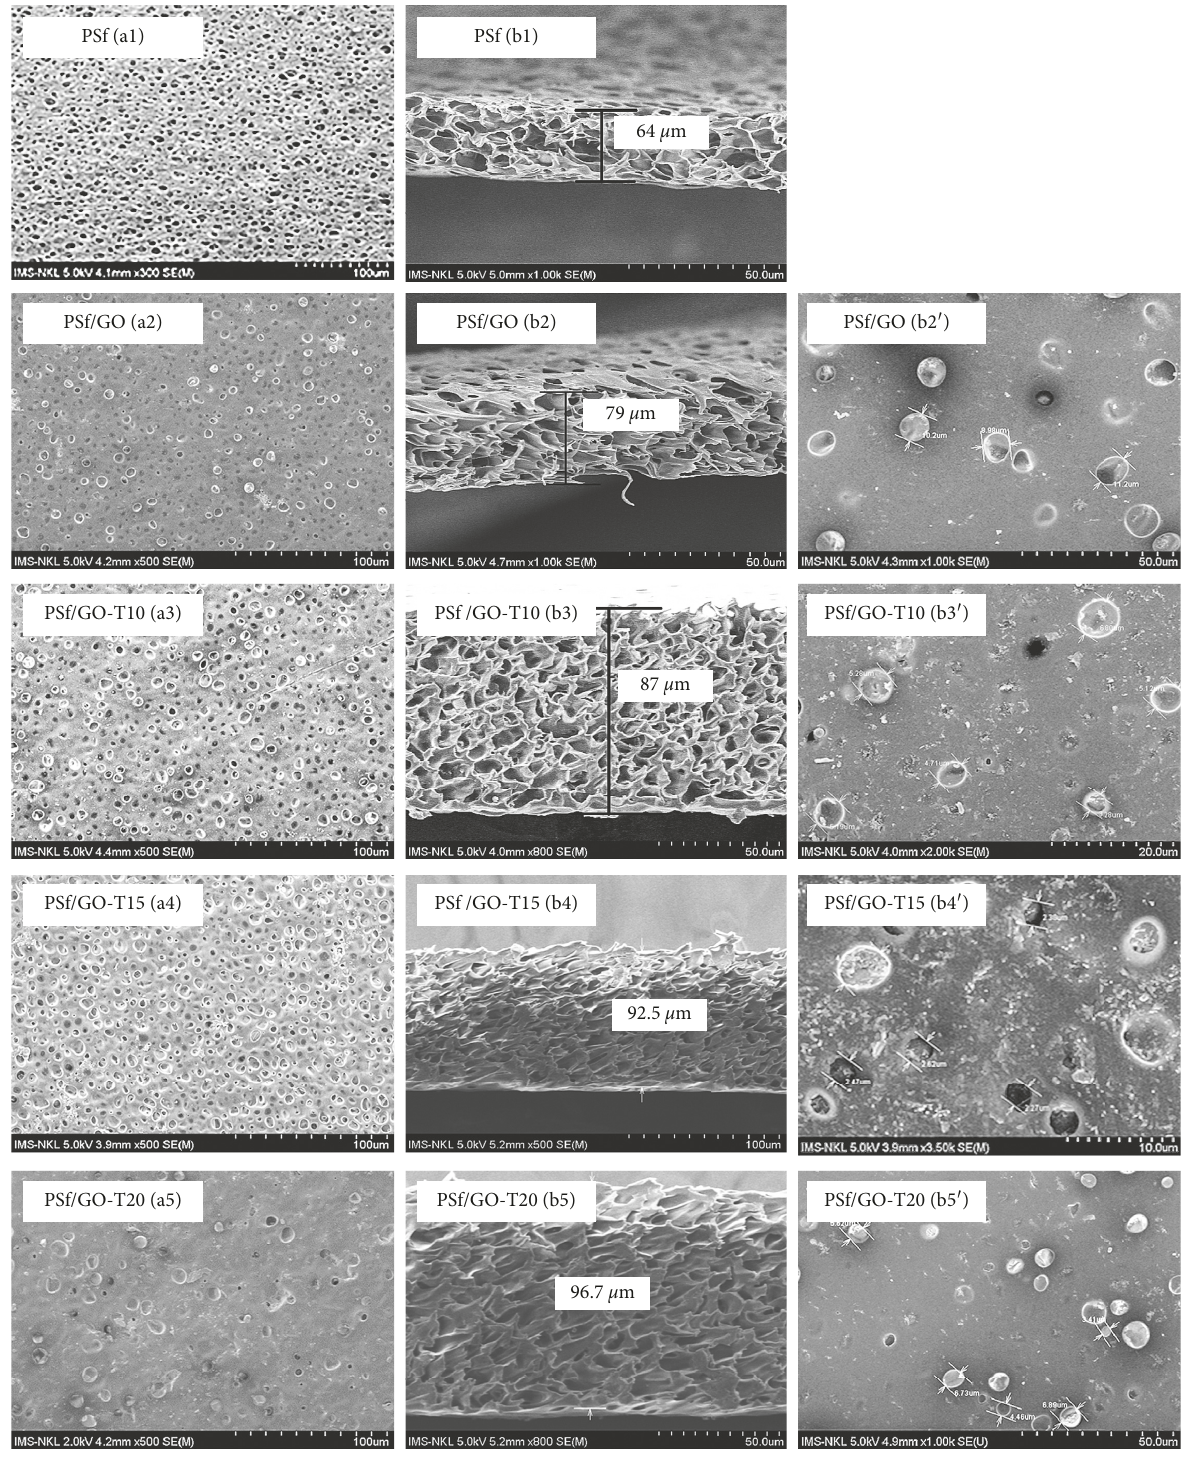
Figure 5: SEM images of the surface (a1, a2, a3, a4, a5; b2 and PSf/GO-TiO 2 the blended membranes became more hydrophilic, and the obtained experimental results related to membrane sepa- ration performance are shown below.